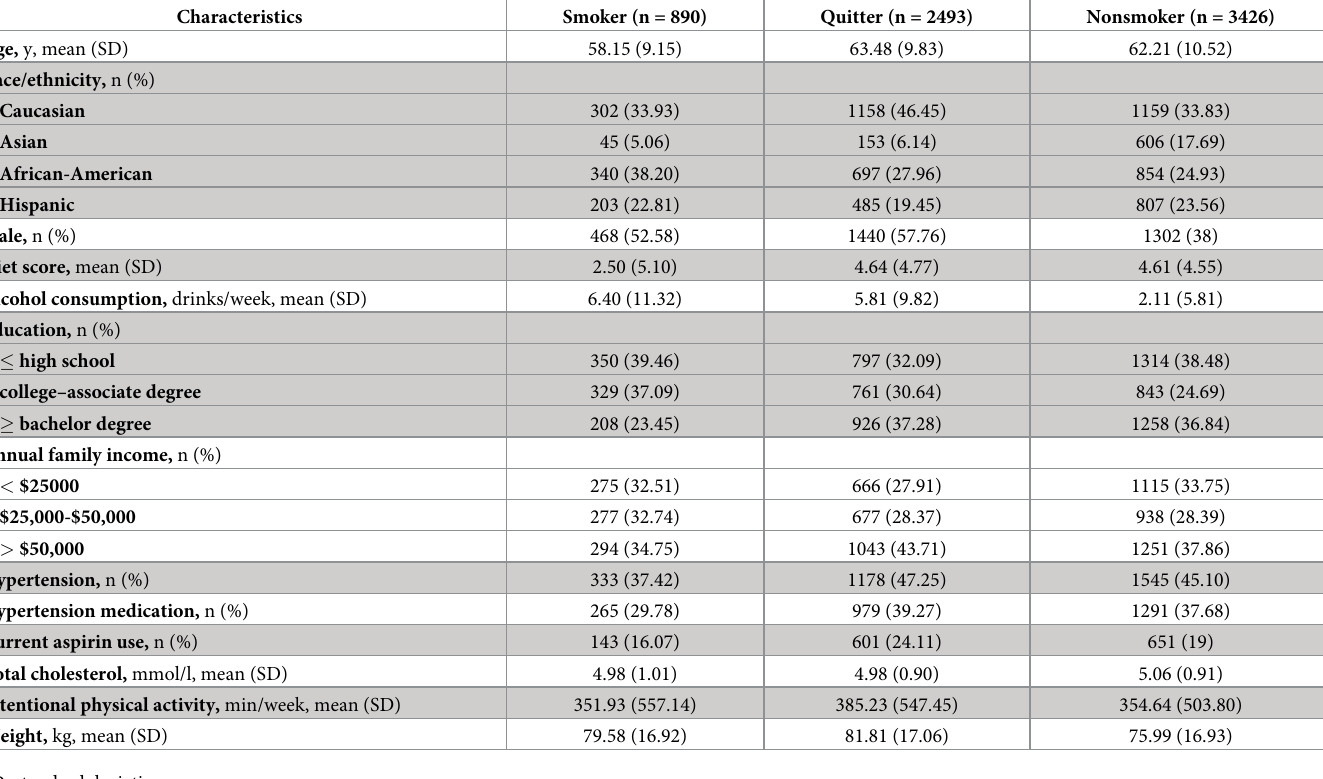
Table 1. Baseline characteristics of eligible participants in the Multi-Ethnic Study of Atherosclerosis, United States, 2000–2011.